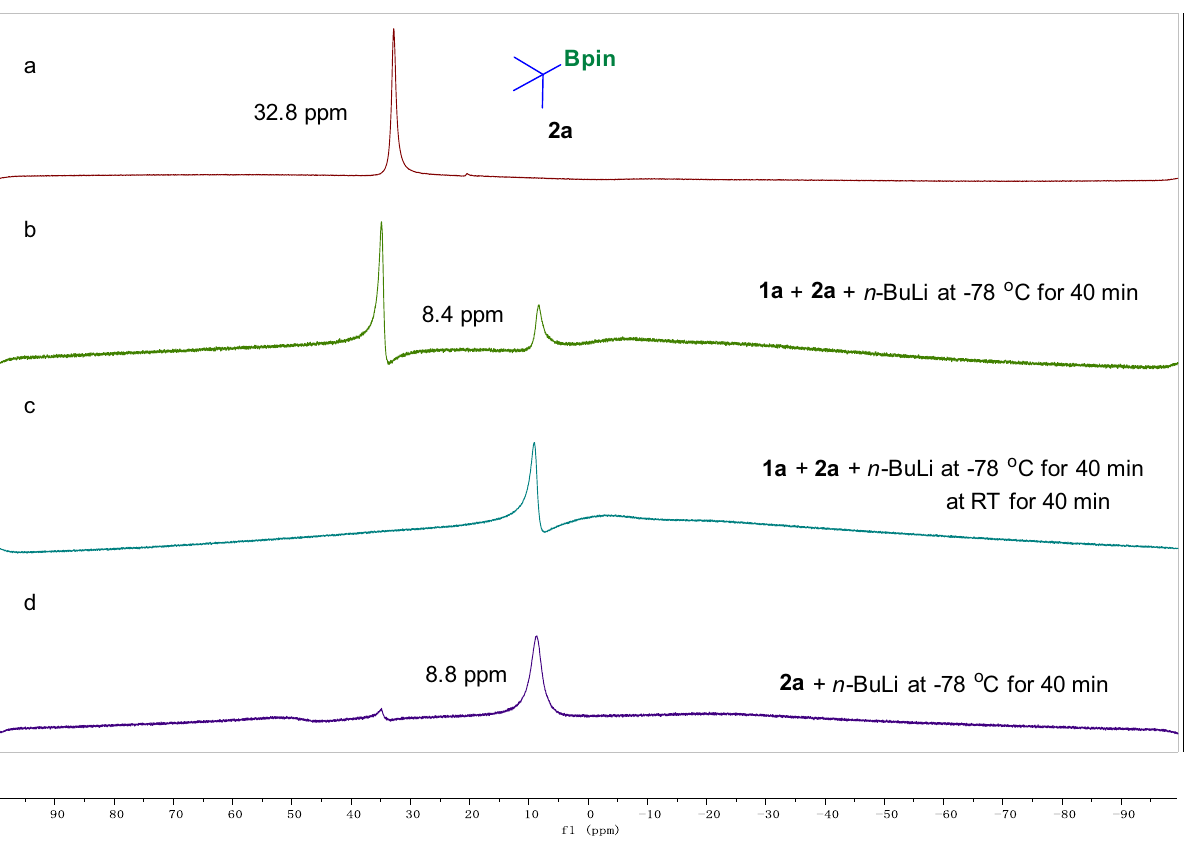
Fig. 7 11 B NMR analysis of the reaction in d 8 -THF. a The boron peak of tert -butylboronic acid pinocol ester ( tert- BuBpin, 2a ); b 1a and n- BuLi were added to the solution of 2a and stirred at − 78 °C for 40 min; c After ( b ) the reaction was allowed to warm to room temperature and stir for another 40 min; ( d ) Only added n -BuLi to the solution of 2a and allowed the mixture was stirred at − 78 °C for 40 (Fig. 6E). In the fi rst case, styrene ( 18 ) was added to the standard